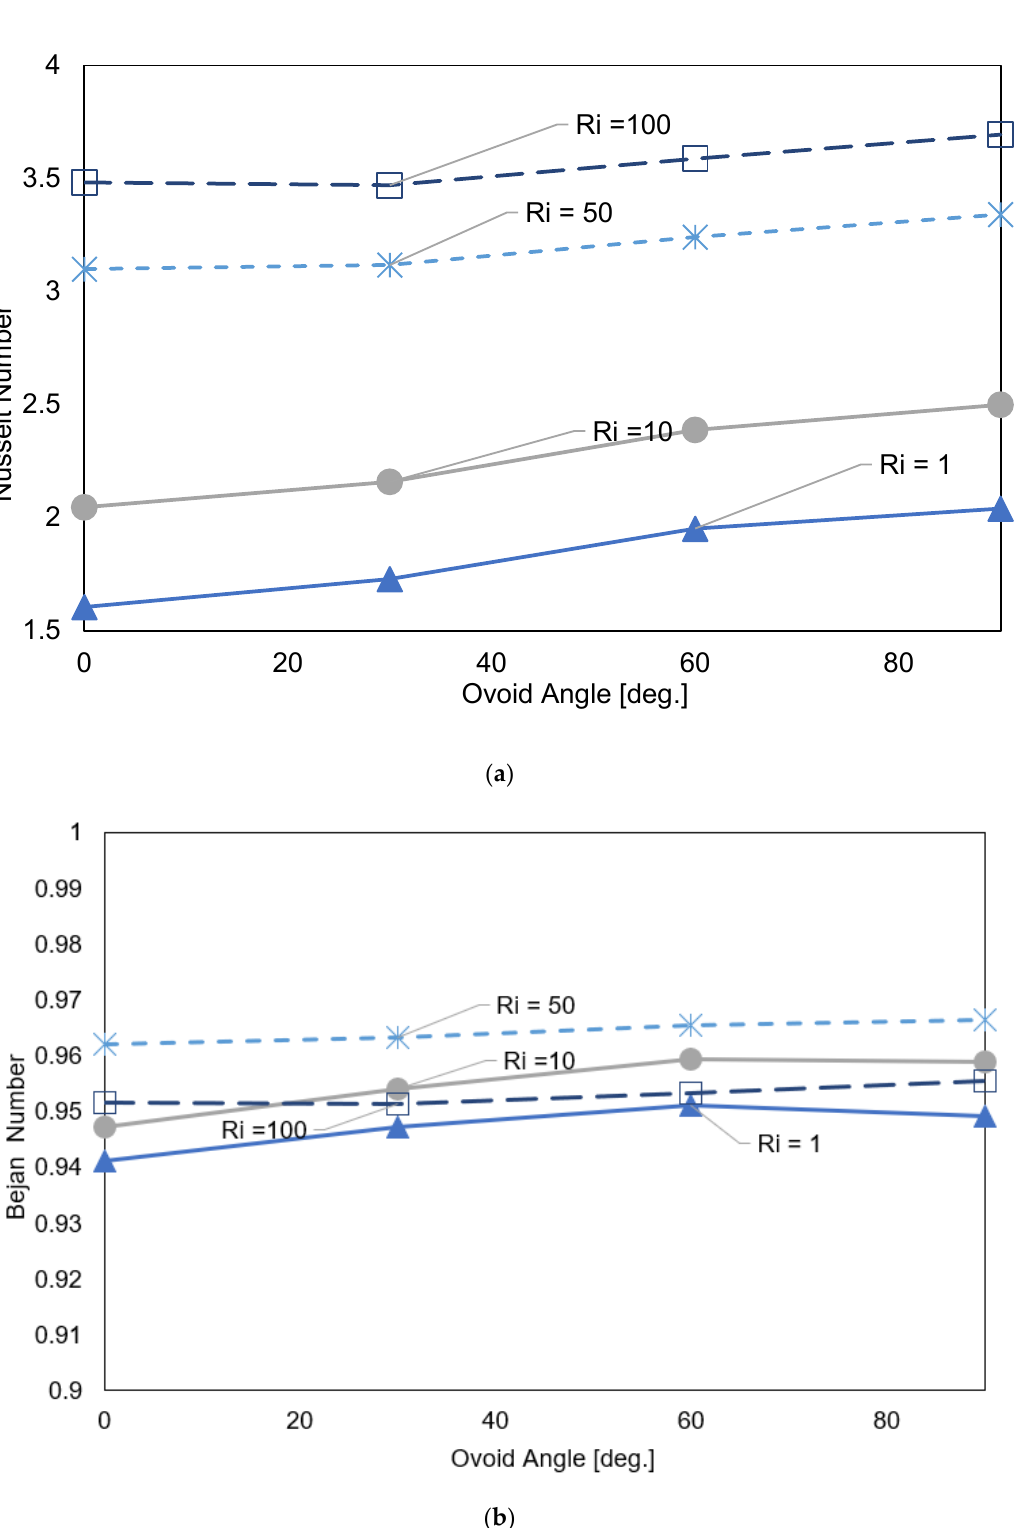
( b ) Figure 5. ( a ) Figure 5. ( a ) Nusselt number : γ : 0 ◦ ,30 ◦ ,60 ◦ ,90 ◦ ; N = 4; Ha = 0; Ri = 1, 10, 50, 100; ϕ = 0.02. o o o o ( b ) Bejan number : γ : 0 ◦ ,30 ◦ ,60 ◦ ,90 ◦ ; N = 4; Ha = 0; Ri = 1; ϕ = Nusselt number: 𝛾𝛾 : 0 ,30 , 60 ,90 ; 𝑁𝑁 = 4; 𝐻𝐻𝑎𝑎 = 0; 𝑅𝑅𝑅𝑅 = 1, 10,50,100; 𝜑𝜑 = 0.02 o o o o Bejan number: 𝛾𝛾 : 0 ,30 , 60 ,90 ; 𝑁𝑁 = 4; 𝐻𝐻𝑎𝑎 = 0; 𝑅𝑅𝑅𝑅 = 1; 𝜑𝜑 = 0.02